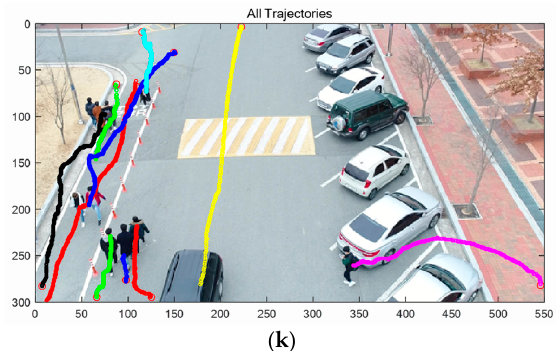
Figure 11. Tracking results, ( a ) Target 1, ( b ) Target 2, ( c ) Target 3, ( d ) Target 4, ( e ) Target 5, ( f ) Target 6, ( g ) Target 7, ( h ) Target 8, ( i ) Target 9, ( j ) Target 10, ( k ) All Targets.